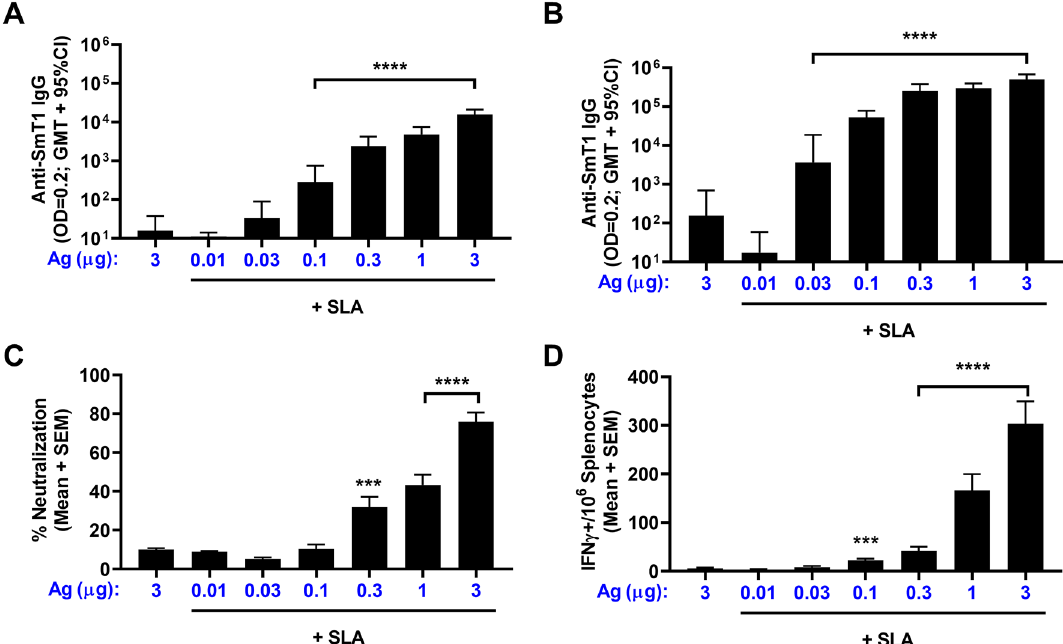
Figure 3. Antigen dose response of SmT1-SLA adjuvanted vaccine formulations. C57BL/6 mice (n = 10/ group) were immunized i.m. with 3 µg of SmT1 alone or 0.01–3 µg of antigen with SLA archaeosomes on Days 0 and 21. Serum was collected on Days 20 ( A ) and 28 ( B ) and analyzed by ELISA to determine the antibody titers. Grouped data is presented as geometric mean + 95% confidence interval. Serum from Day 28 was also analyzed at a final serum dilution of 1:75 by surrogate neutralization assay ( C ). Grouped data is presented as mean + standard error of mean. Splenocytes were harvested on Day 28 and analyzed by IFN-γ ELISpot when stimulated by spike peptide pools ( D ). Values obtained with media alone were subtracted from those measured in the presence of the peptides. Grouped data is presented as mean + standard error of mean (SEM). Statistical significance of differences for the adjuvanted groups vs. the antigen alone control group is shown: ***p < 0.001 and ****p < 0.0001 by one-way ANOVA followed by Tukey’s multiple comparisons